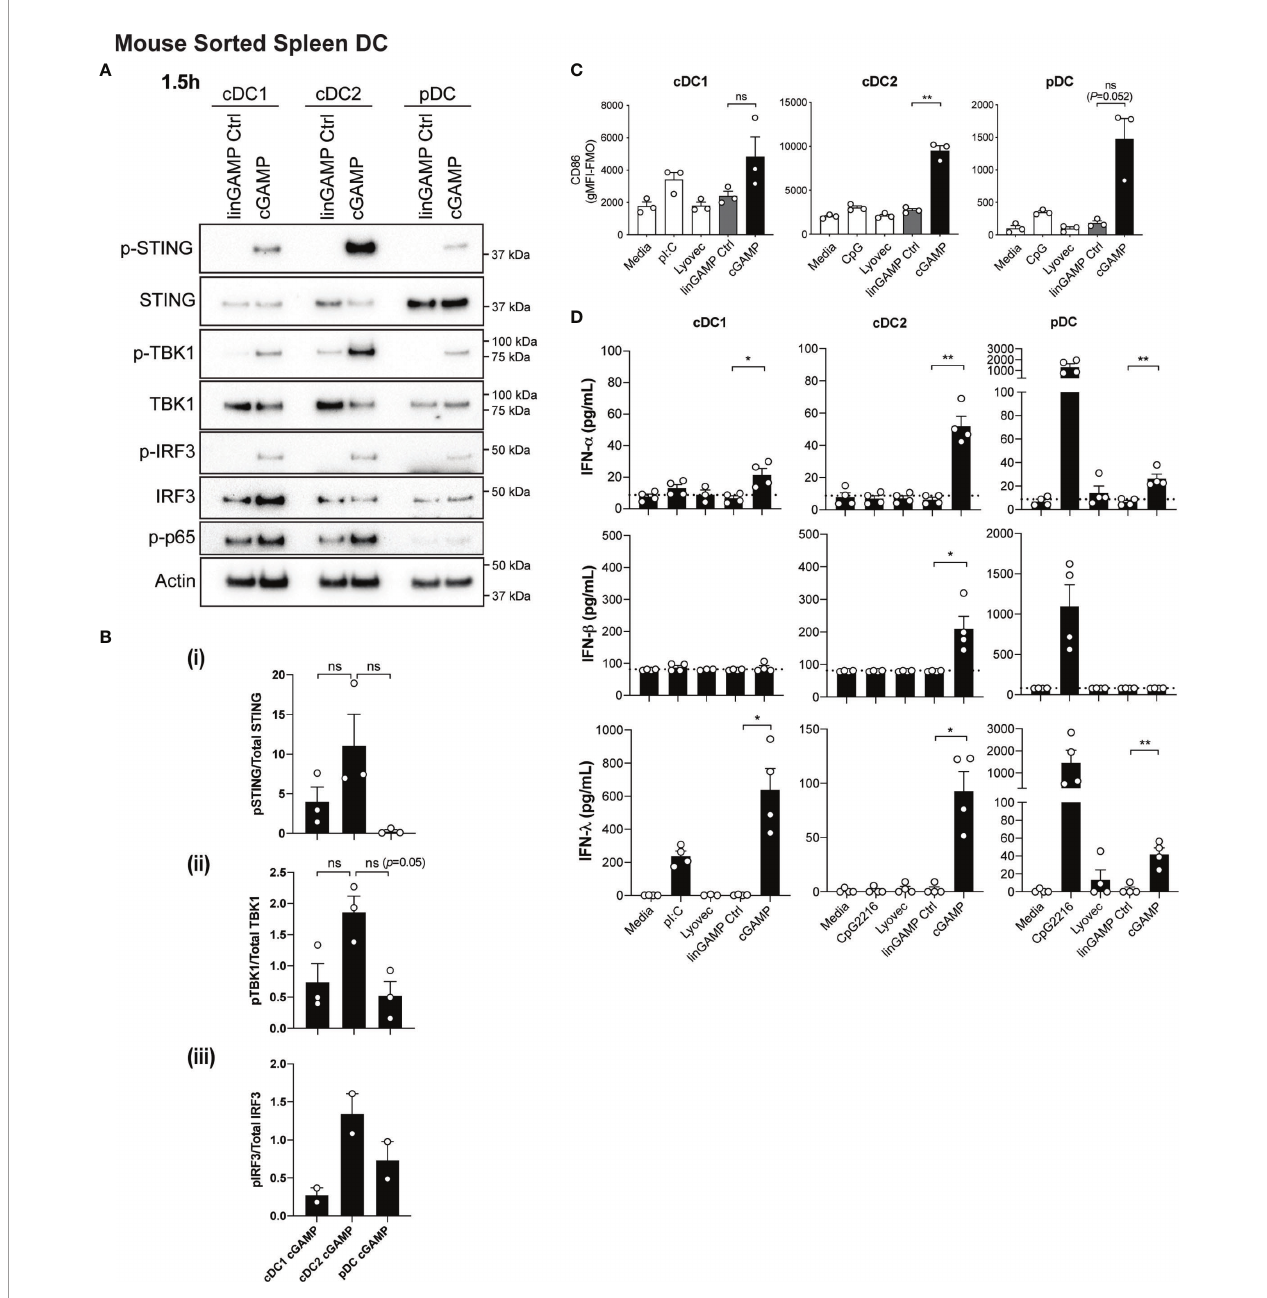
FIGURE 2 | Type I and III IFNs are differentially produced by DC subsets after cGAMP stimulation. (A, B) Sorted splenic mouse cDC1, cDC2 and pDCs (see Supplementary Figure 4A for sorting strategy) from a pool of 11-12 mice were stimulated with 10 nmol 3 ’ 3 ’ cGAMP or its linearized control ligand (linGAMP Ctrl) complexed with lyovec for 1.5 hrs. (A) Cells were then lysed and blotted using the indicated antibodies. Data shown represents 1 of 2-3 independent experiments. (B) Densitometric analysis of (i) phosphorylated STING relative to total STING (ii) phosphorylated TBK1 relative to total TBK1 and (iii) phosphorylated IRF3 relative to total IRF3 immunoblots from 2-3 independent experiments are shown. Bar graphs show mean ± SEM. (C) Sorted splenic mouse cDC1, cDC2 and pDCs from a pool of 15-17 mice were stimulated with 10 nmol 3 ’ 3 ’ cGAMP or its linearized control ligand (linGAMP Ctrl) complexed with lyovec, lyovec alone, 0.5 m M CpG2216 or 100 m g/mL pI:C for 18 h. CD86 expression on DC subsets was determined using fl ow cytometry. Bar graphs represent the mean difference between geometric mean fl uorescence intensities (gMFI) of stained samples and fl uorescence minus one (FMO) controls ± SEM from 3 independent experiments. (D) Sorted splenic mouse cDC1, cDC2 and pDCs from a pool of 15-17 mice were stimulated with 10 nmol 3 ’ 3 ’ cGAMP or its linearized control ligand (linGAMP Ctrl) complexed with lyovec, lyovec alone, 0.5 m M CpG2216 or 100 m g/mL pI:C in the presence of 0.2 ng/mL GM-CSF for 18 hrs. IFN production in cell culture supernatants was analysed by ELISA (IFN- a and IFN- l ) or fl ow cytometric bead assay (IFN- b ). Bar graphs represent mean ± SEM from 4 independent experiments. Statistical analyses were performed using two-tailed Paired Student ’ s t test where * P < 0.05, ** P < 0.01 and ns, not signi fi